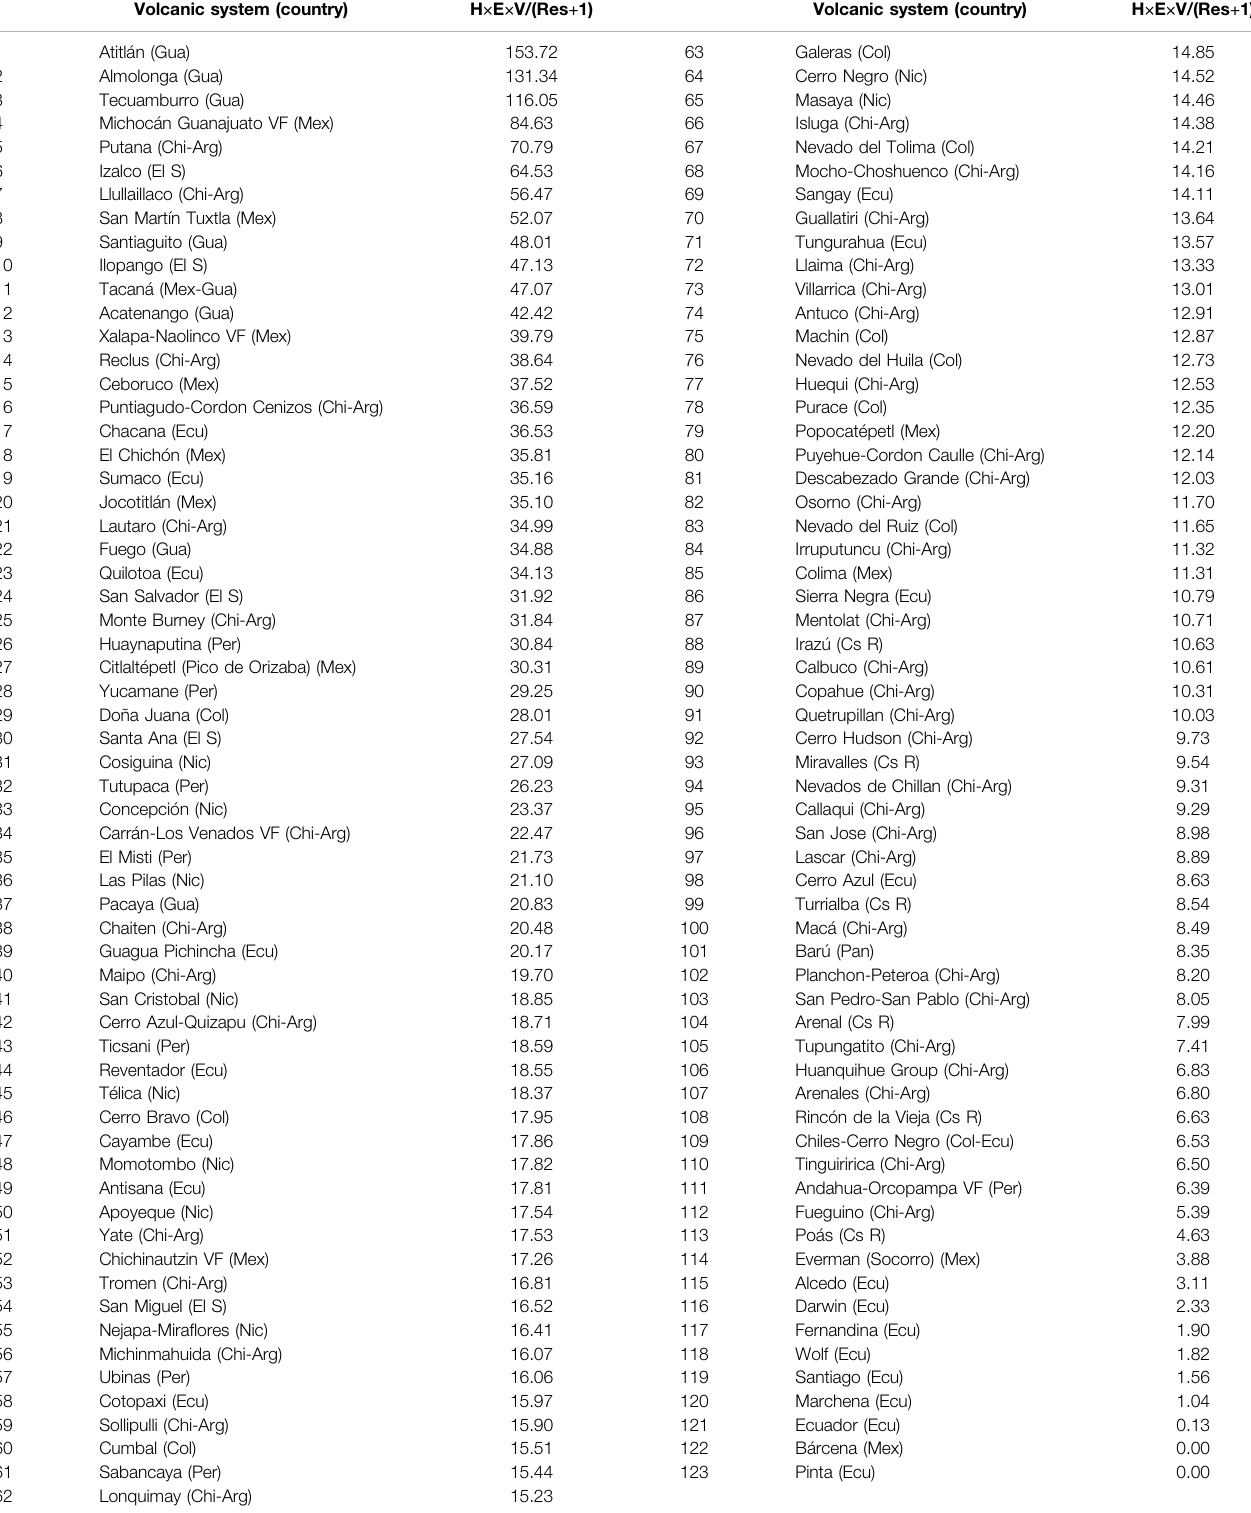
TABLE 5 | VRR (2) for the Latin America volcanic systems with activity in the past 1,000 years. The complete table of results with the score of all factors is available in the Supplementary Material 1 . Volcanic system (country) H × E × V/(Res + 1) Volcanic system (country) H × E × V/(Res + 1) Atitlán